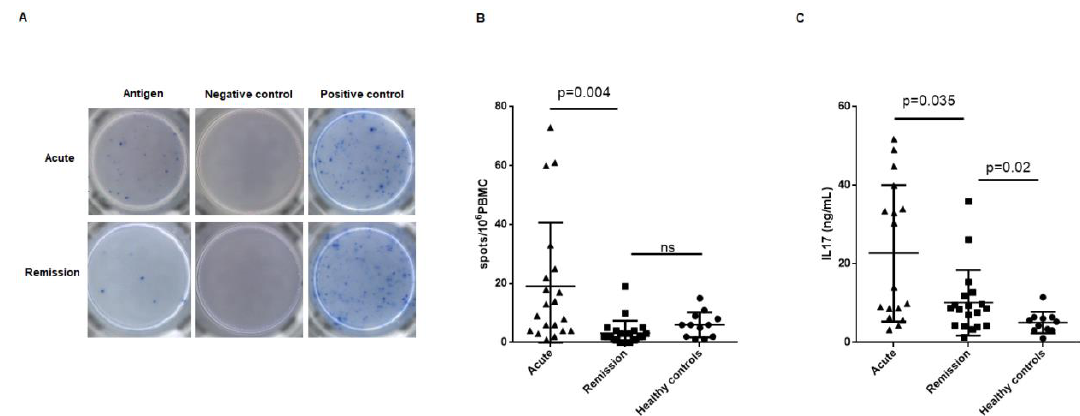
Figure 1. Th17 response to the stimulation with MPO or PR3. ( A ) Representative wells of an enzyme-linked immunosorbent spot (ELISpot) plate corresponding to an acute and a remission phase patient. Antigen wells contain PBMCs stimulated with proteinase 3 or myeloperoxidase. Negative control wells contain PBMCs cultured with medium alone. Positive control wells contain PBMCs stimulated with phytohemagglutinin. ( B ) Number of specific IL-17 producing cells in response to MPO or PR3 in the ELISpot assay. Number of spots / 10 6 PBMCs was significantly higher in the acute phase patients, and lowered in remission to healthy control level. ( C ) Concentration of IL-17 present in the supernatant of PBMCs culture after stimulation with MPO or PR3 over 48 h. Supernatant IL-17 concentration was higher in acute patients compared to remission patients. Supernatant IL-17 concentration did not normalize in remission. Th17—T helper 17; MPO—myeloperoxidase; PR3—proteinase 3; AAV—anti-neutrophil cytoplasm antibodies associated vasculitis; PBMCs—peripheral blood mononuclear cells; IL-17—interleukin-17.